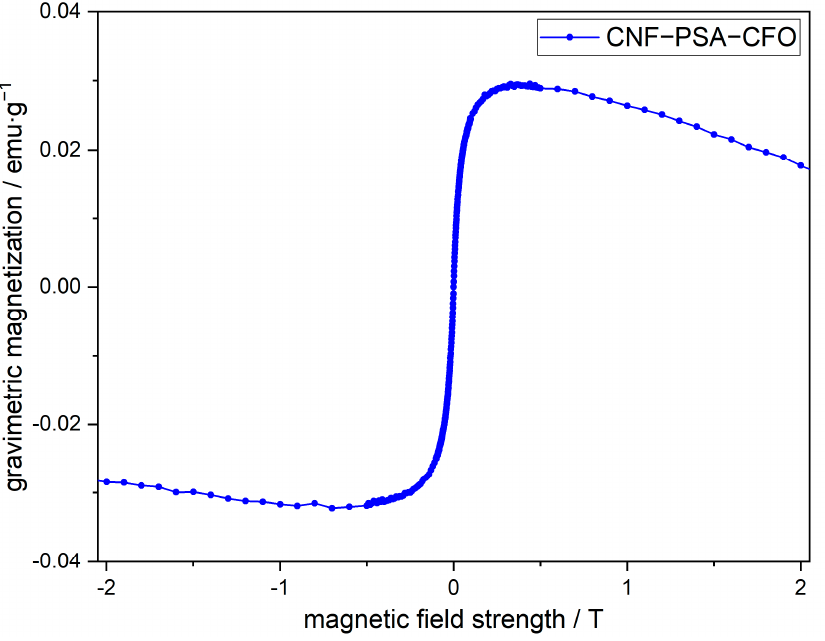
Figure 7. Magnetization as a function of the applied magnetic field of CNF–PSA–CFO.